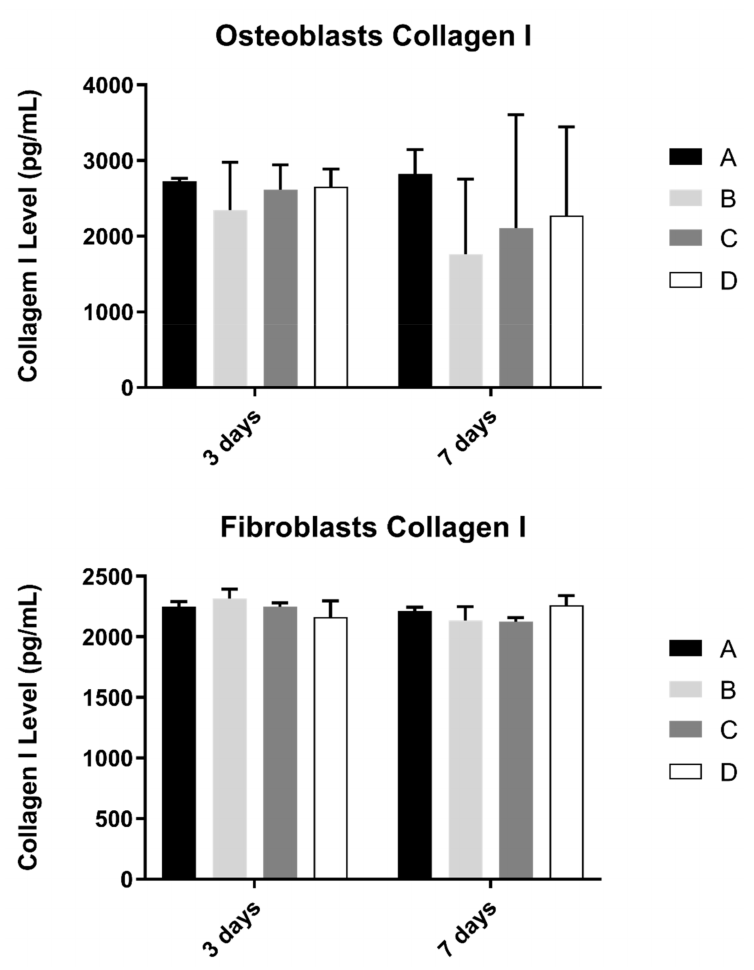
Figure 6. Collagen type I concentration (in pg/mL) obtained in osteoblasts and fibroblasts in all study groups at 3 and 7 days (N = 4), presented as mean and standard deviation (error bars), for each study group (as described in Table 1). The Kruskal–Wallis test, followed by Dunn’s post-hoc tests, was used for comparison between study groups. Statistical significance: p <